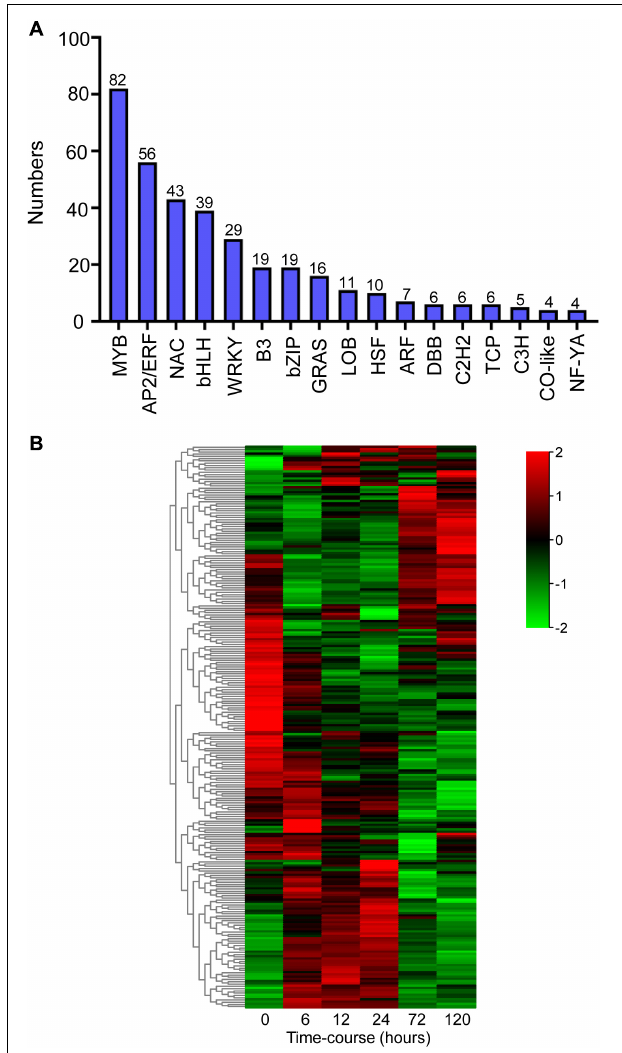
FIGURE 5 | Identification of differentially expressed transcription factors (TFs) after BA stress. (A) Numbers of predicted TFs belongs to different families. (B) Hierarchical cluster heatmap of the common TFs (MYB, AP2/ERF, NAC, bHLH, and WRKY families). Gradient colors represent the gene expression levels; red represents high expression, whereas green represents low expression.